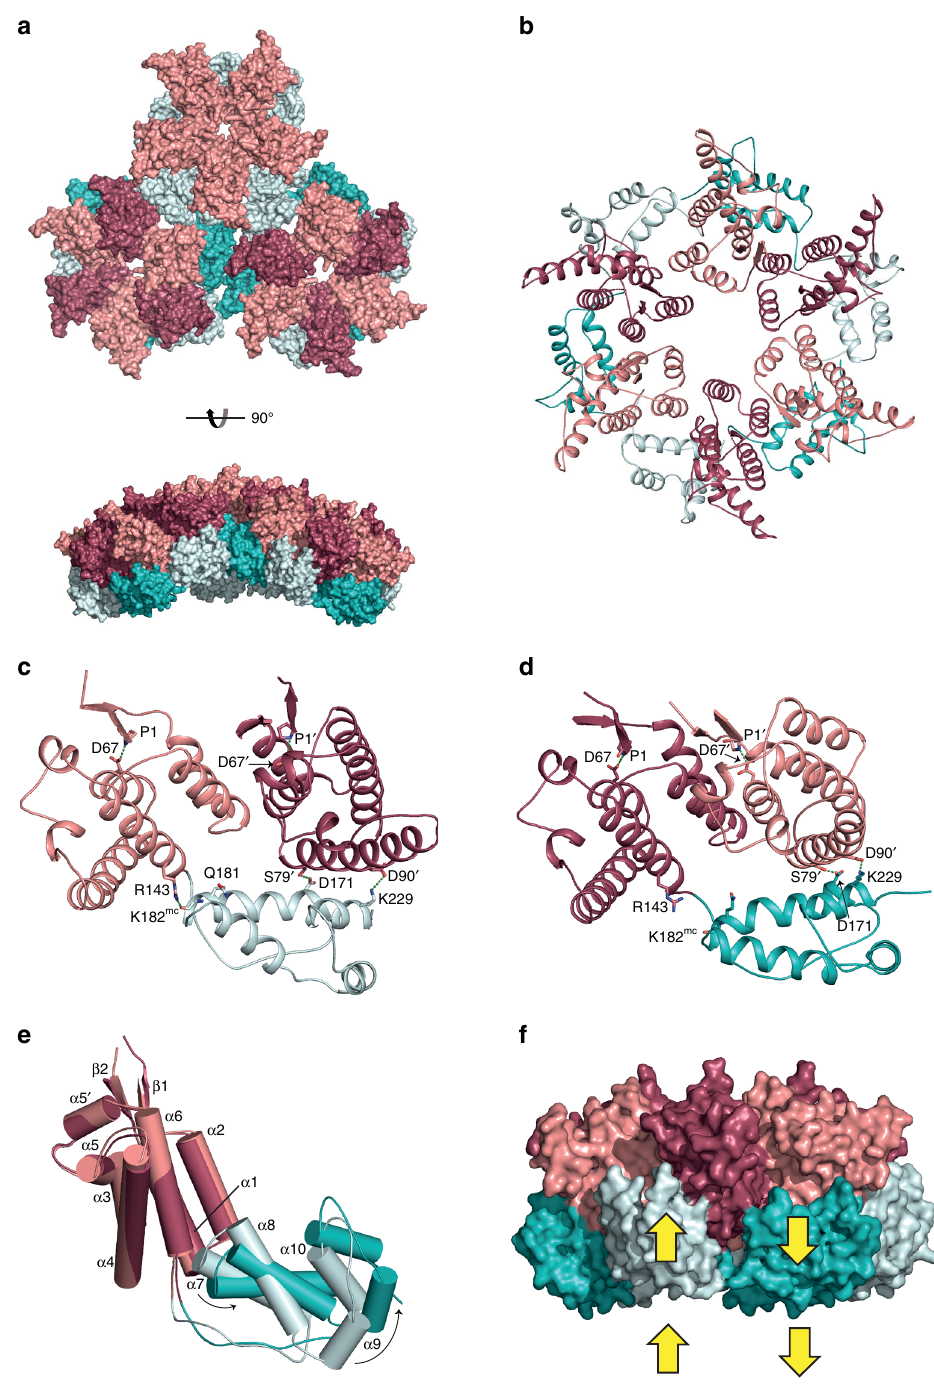
Fig. 6 Variation of hexamer – pentamer and hexamer – hexamer interfaces in the T = 3 particle. a A hexamer – pentamer – hexamer subassembly from the T = 3 particle shown in surface representation viewed from the exterior of the shell (upper) and from the side, highlighting the curvature (lower). NTDs and CTDs in the pentamer and those in the hexamer that interface with pentamers are coloured pink and cyan, respectively. NTDs and CTDs in the hexamer that interface with hexamers are coloured red and teal, respectively. b Cartoon representation of a hexamer from the T = 3 particle viewed down the icosahedral three-fold axis (colouring as in a ). c , d NTD – CTD intra-hexamer interactions in the T = 3 hexamer. c A CA monomer, NTD (pink) and CTD (cyan) that interfaces with a neighbouring pentamer, and the adjacent NTD shown in red. d A CA monomer, NTD (red) and CTD (teal) that interfaces with a neighbouring hexamer, and the adjacent NTD is shown in pink. Residues making interactions are shown as sticks with hydrogen bonds shown as dashes, the prime ( ′ ) notation indicates the adjacent NTD and “ mc ” indicates a main-chain interaction. e NTD (pink/red) alignment of monomers in T = 3 hexamers showing the relative displacement of the CTD when the protomer interacts with either a neighbouring pentamer (cyan) or a neighbouring hexamer (teal). f Hexamer surface representation viewed perpendicular to the symmetry axis showing alternate CTDs displaced upwards (cyan, pentamer facing) and downwards (teal, hexamer facing). NTDs are coloured pink or red as in a